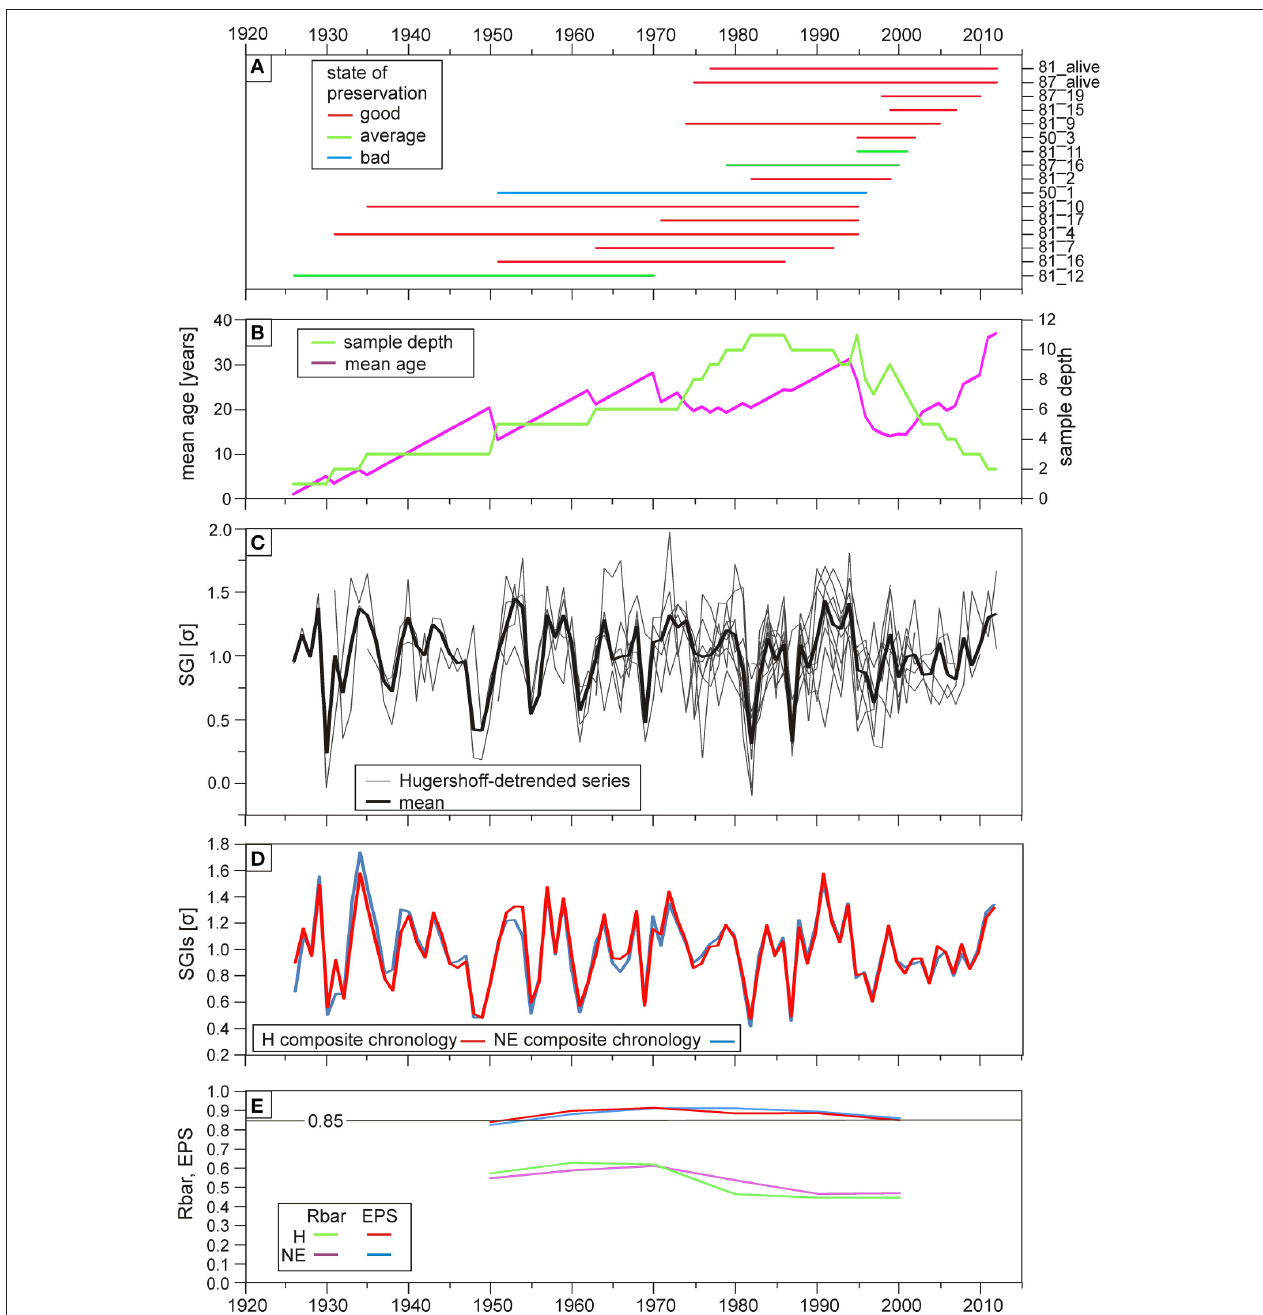
FIGURE 4 | Details of the Madeira composite chronology from the G. vangentsumi shells. (A) Lifespan of the cross-dated shells, in which the first part of their sample code is the number of the corresponding collection site from Figure 2 color-coded by their preservation state. (B) Running mean age (purple line) and sample depth (green line) at a given time. (C) Individual Hugershoff-detrended growth increment indices (gray lines) with mean (black line). (D) Hugershoff (red line) and negative exponential (blue line) detrended (arstan) chronologies. (E) EPS and Rbar statistics of the two different chronologies calculated in 20 year running